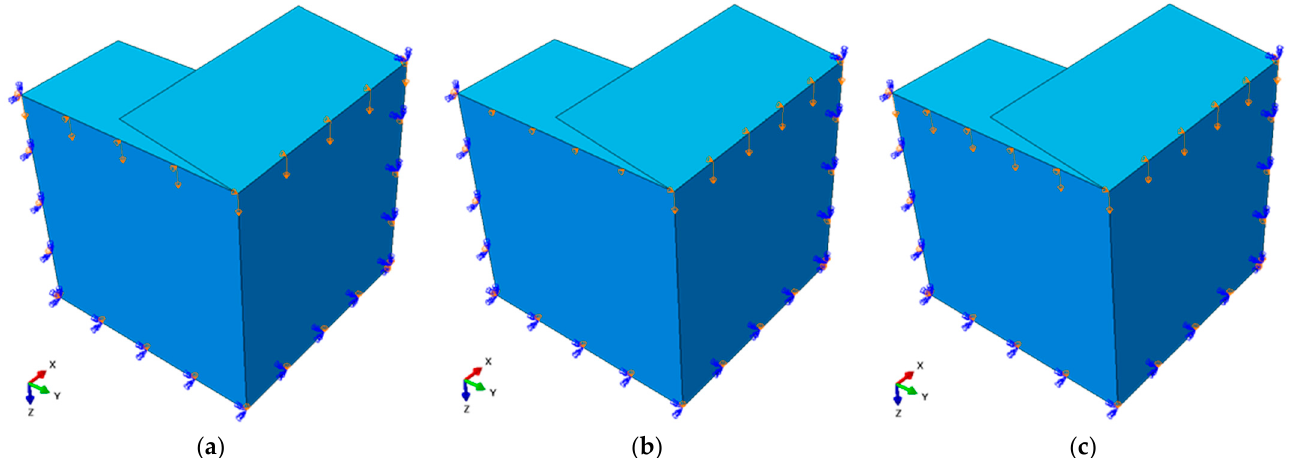
Figure 6. Boundary conditions for the case of: ( a ) the non-offset package; ( b ) the package with offset flaps (first step); ( c ) the package with offset flaps (second step).